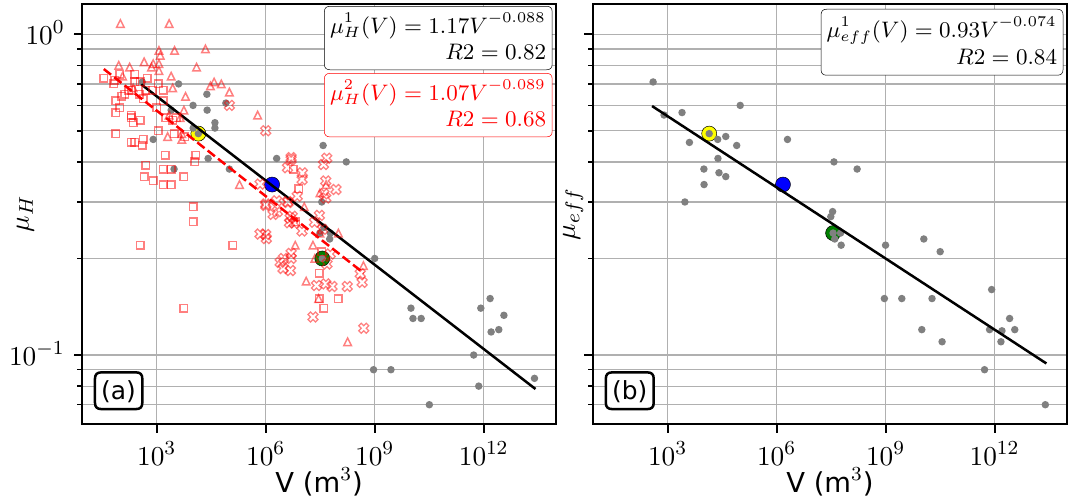
Figure 5. Empirical landslide databases. ( a ) µ H VS landslide volume V . Grey circles: DB1 . Red marker: DB2 . squares: rockfalls and rockfalls avalanches from [3]. Triangles: debris flow, debris slides and debris avalanches from [3]. Crosses: Rock avalanches from [31]. Black line: power law regression result for DB1 (equation given in black). Red dashed line: power law regression result for DB2 (equation given in red). ( b ) µ ef f VS landslide volume V , for DB1 . Black line: power law regression result for DB1 (equation given in black). Yellow circle: observations for Fei Tsui Road debris slide. Blue circle: observations for the most import destabilization of the Samperre cliff in 2018. Green circle: observations for the Franks